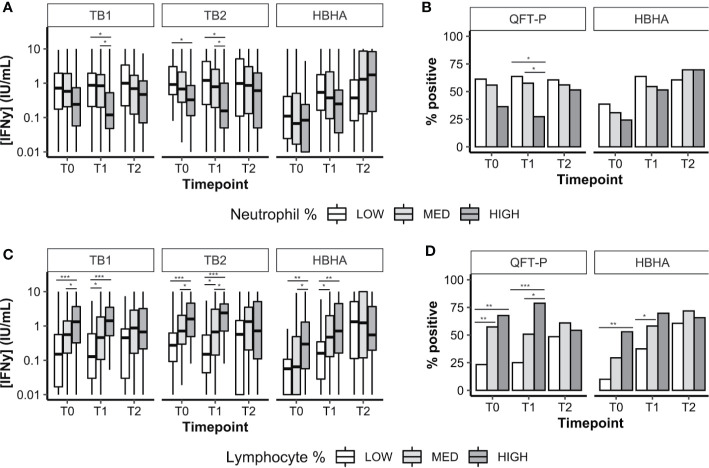
Plasma IFN-γ response to TB-specific QFT-P antigens or HBHA stimulation in patients stratified by WBC counts over the course of TB therapy. (A, C) Quantitative IFN-γ response. Data are given as median + interquartile range and were compared using Kruskal–Wallis’ test with Dunn’s post-hoc when necessary. (B, D) Data were given as a percentage of each group and were compared using Fisher’s Exact Test with Bonferroni’s correction when necessary. Positivity was set at 0.75 IU/ml for QFT-P TB1, 0.71 IU/ml for QFT-P TB2 (the overall QFT-P result was positive if TB1 and/or TB2 were positive) and at 0.22 IU/ml for HBHA, based on ROC analyses. Low, medium, and high WBC or lymphocyte groups were defined as follows: low: <1st quartile; medium: 1st–3rd quartiles; high: >3rd quartile. WBC, white blood cells; T0, baseline; T1, baseline + 2 months; T2, end of treatment; *p < 0.05; **p < 0.01; ***p < 0.001.